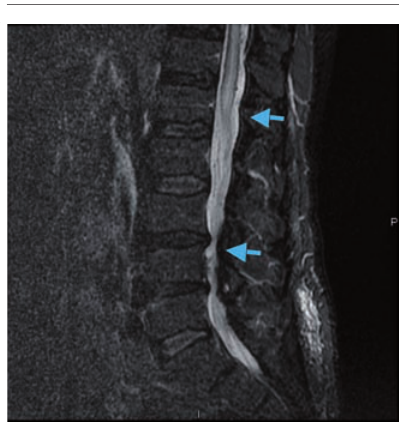
Figure 6. Axial T2 sequence shows hyper intense T2 signal in the central aspect of the lumbar spinal cord with several promi- nent intradural flow voids (arrow).